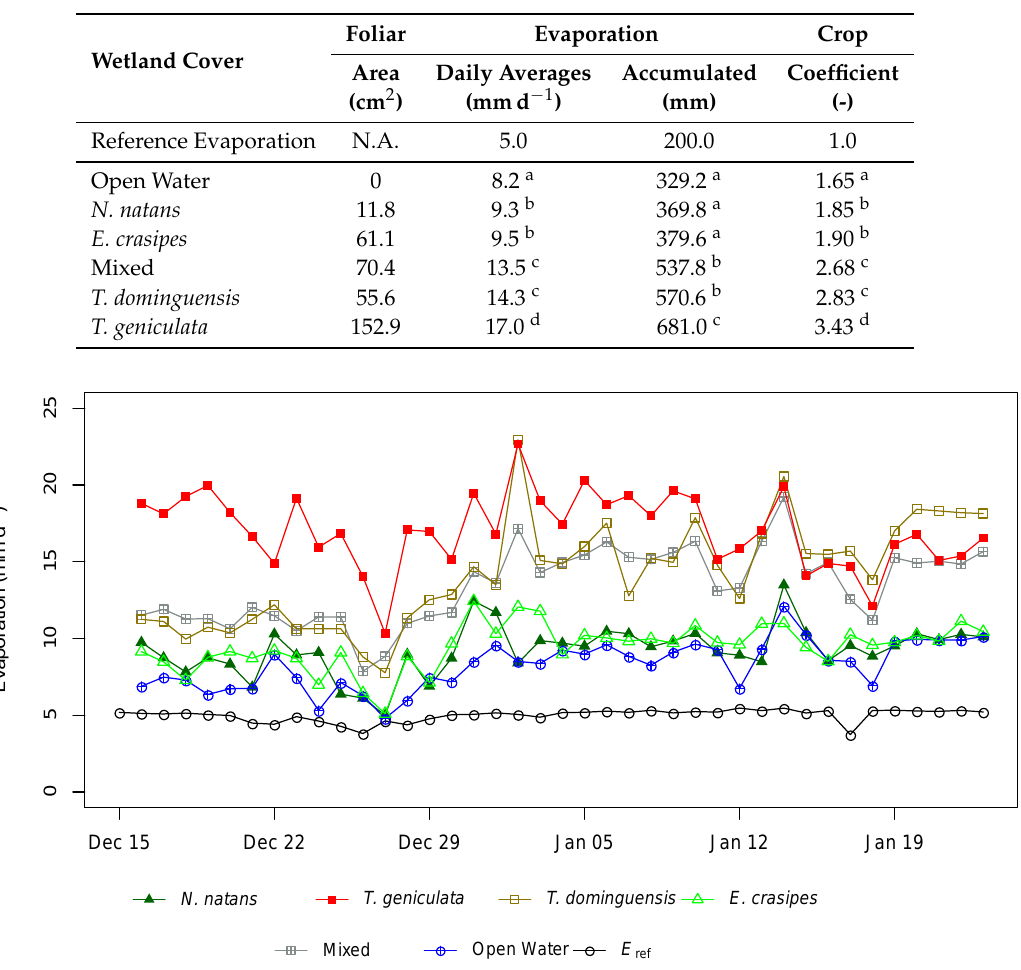
Figure 7. Mean daily evaporation from six wetland covers of Palo Verde National Park, Costa Rica. Sampling period: 40